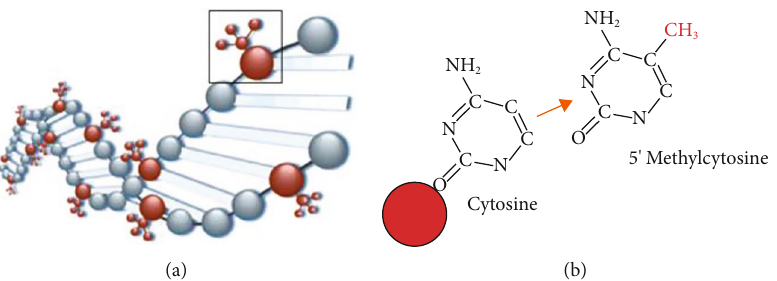
Figure 2: (a) Cytisine residues in DNA are methylated when they present in CG dinucleotide shape. (b) Methylation of CpG islands is the attachment of a methyl group to the 5 position of cytosine in the promoter zone of genes, thereby inhibiting transcription DNA. Reproduced with permission from